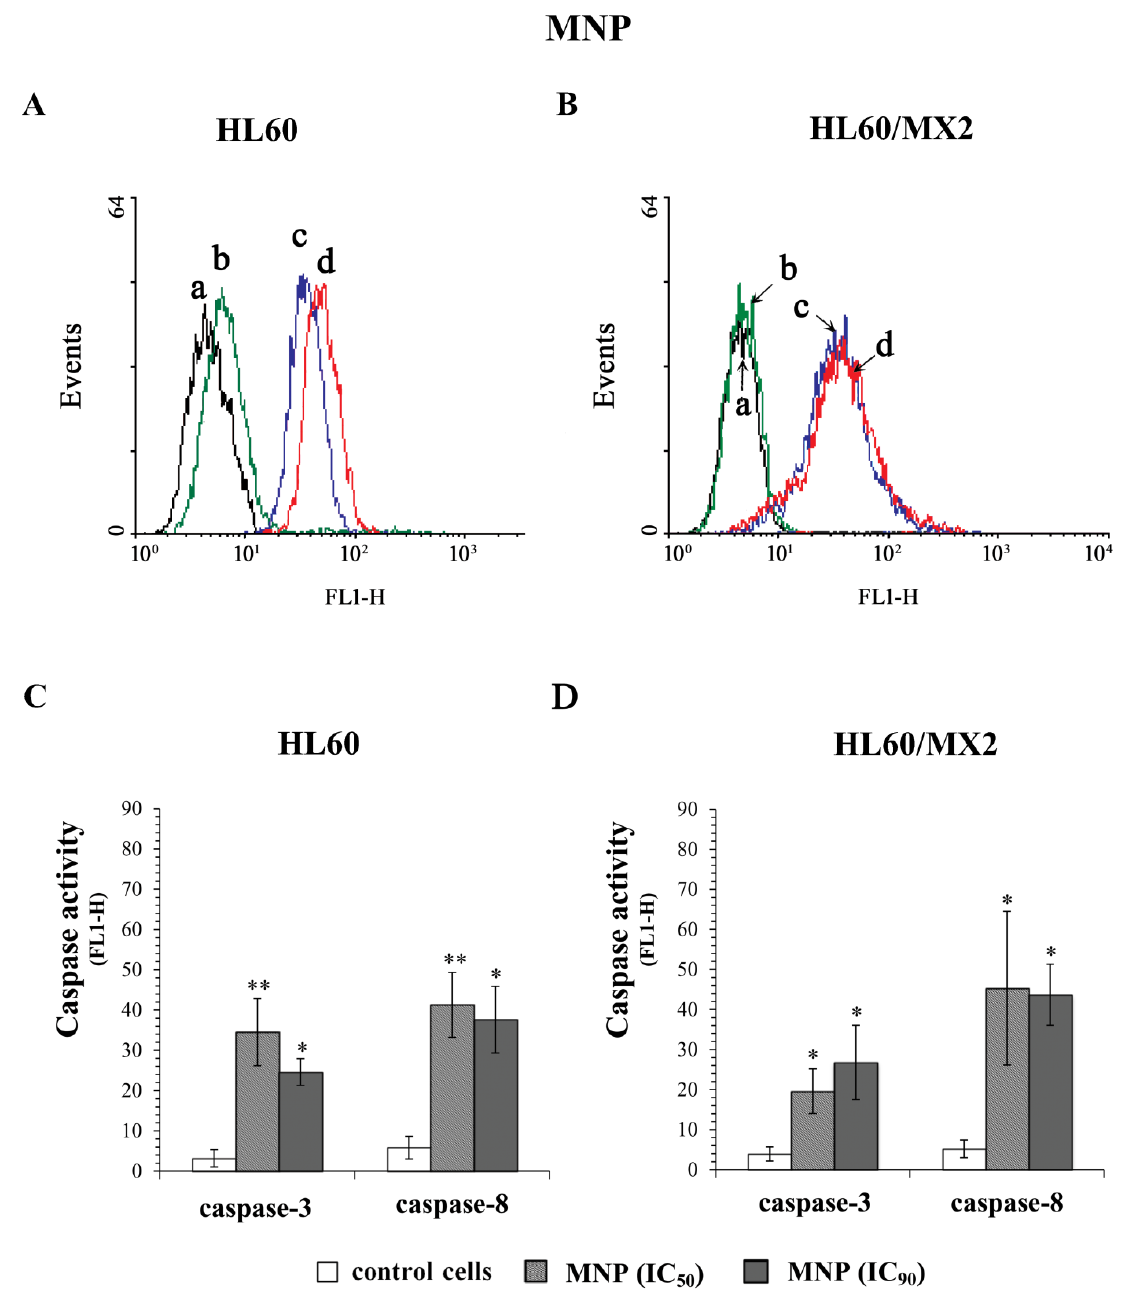
Figure 8. Caspase-3 and caspase-8 activity in sensitive HL60 ( A , C ) and resistant HL60/MX2 ( B , D ) leukaemia cells treated with MNP. The cells were incubated at 37 ◦ C with MNP at IC 50 (24.3 µ M for HL60 cells and 20.5 µ M for HL60/MX2 cells) or at IC 90 (82.1 µ M for HL60 cells and 77.3 µ M for HL60/MX2 cells), respectively, for 72 h. The activity of caspases was determined